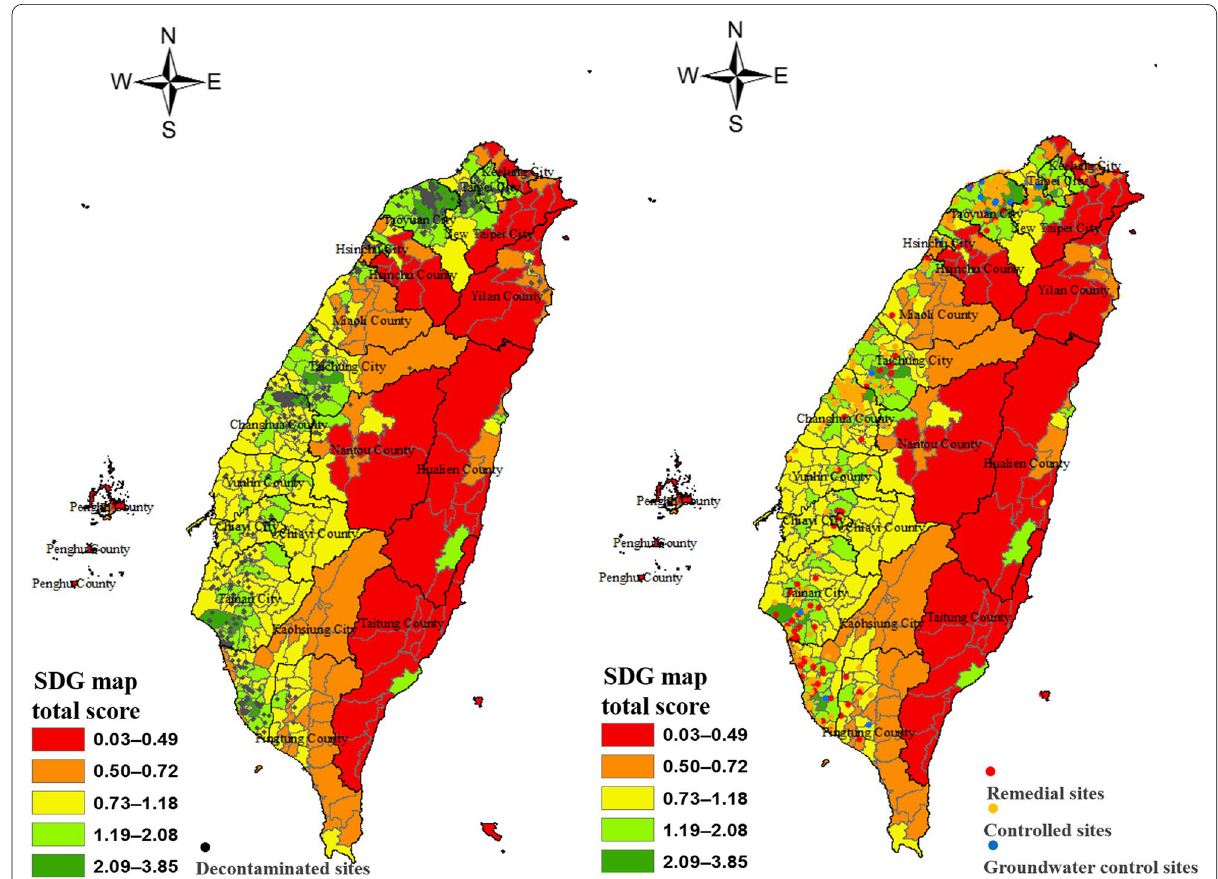
Fig. 5 Sustainable zones of brownfield redevelopment in Taiwan (until